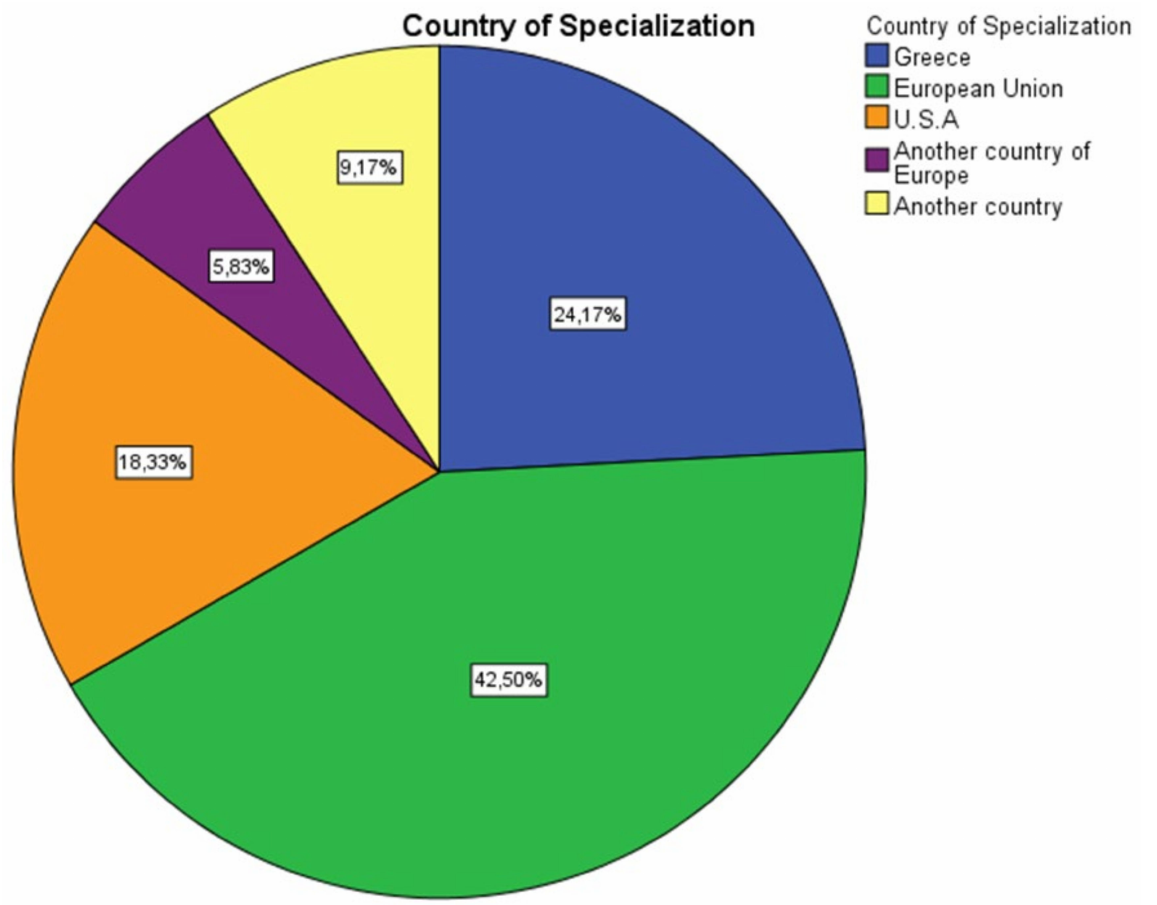
Figure 3. Country of orthodontic